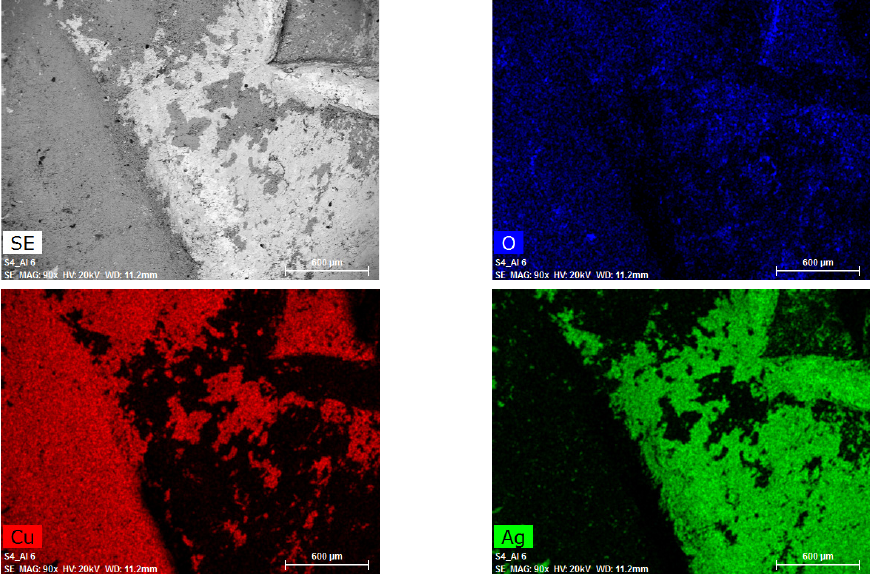
Figure 3. SE image and X-ray maps on the surface of antoninianus no. A48 obtained by SEM-EDX.